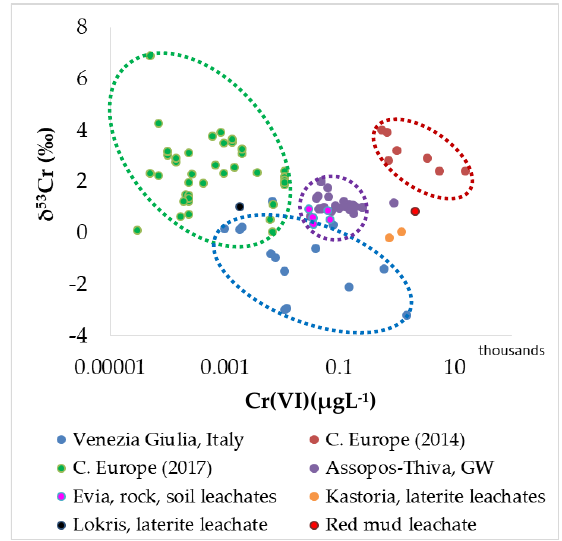
Figure 5. Plot of the δ 53 Cr values versus Cr(VI) in contaminated by Cr(VI) groundwater by industrial activities in the Friuli Venezia Giulia (Italy), the Czech Republic (Central Europe), the Assopos, Thiva basin affected by both industrial activities and natural processes, and Central Evia of geogenic origin. Data from [82,132,138–140].